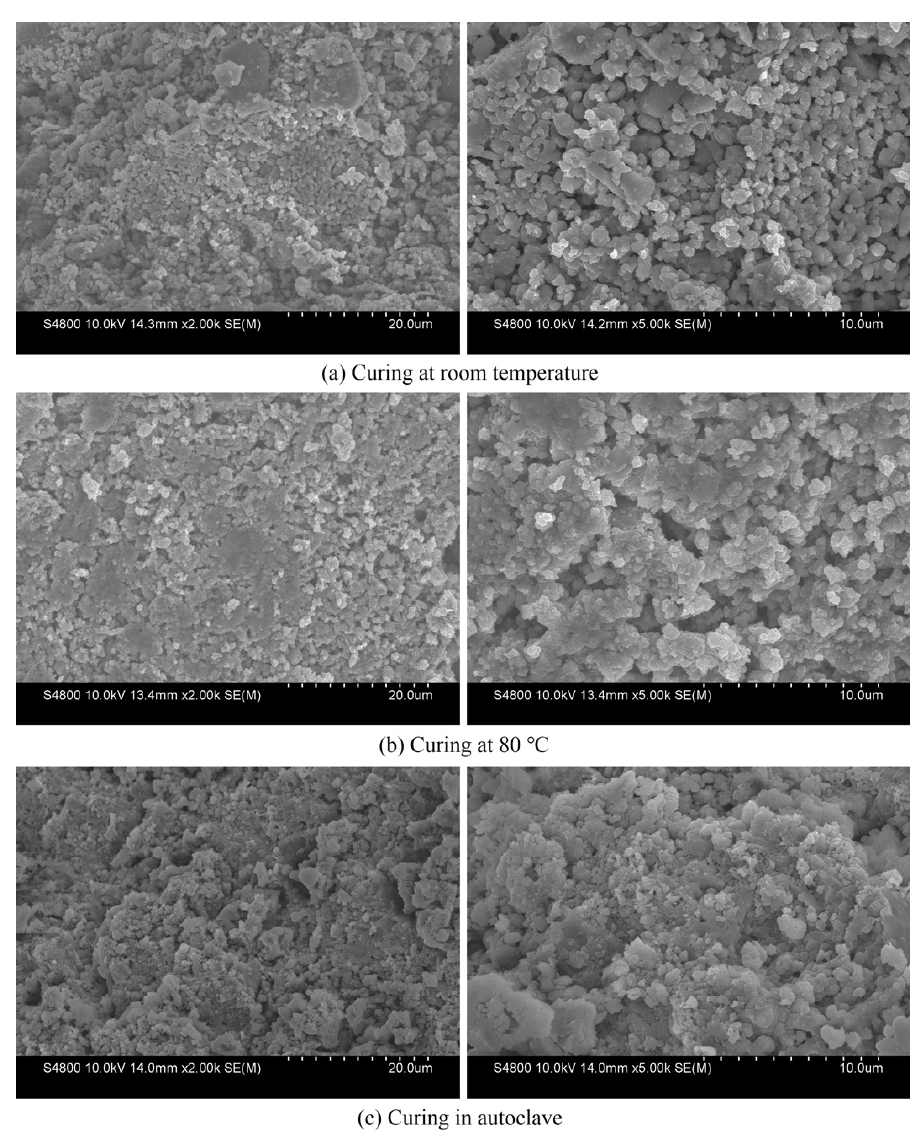
Figure 5. SEM micrographs of the RM-MK geopolymers with a 50% red mud content.